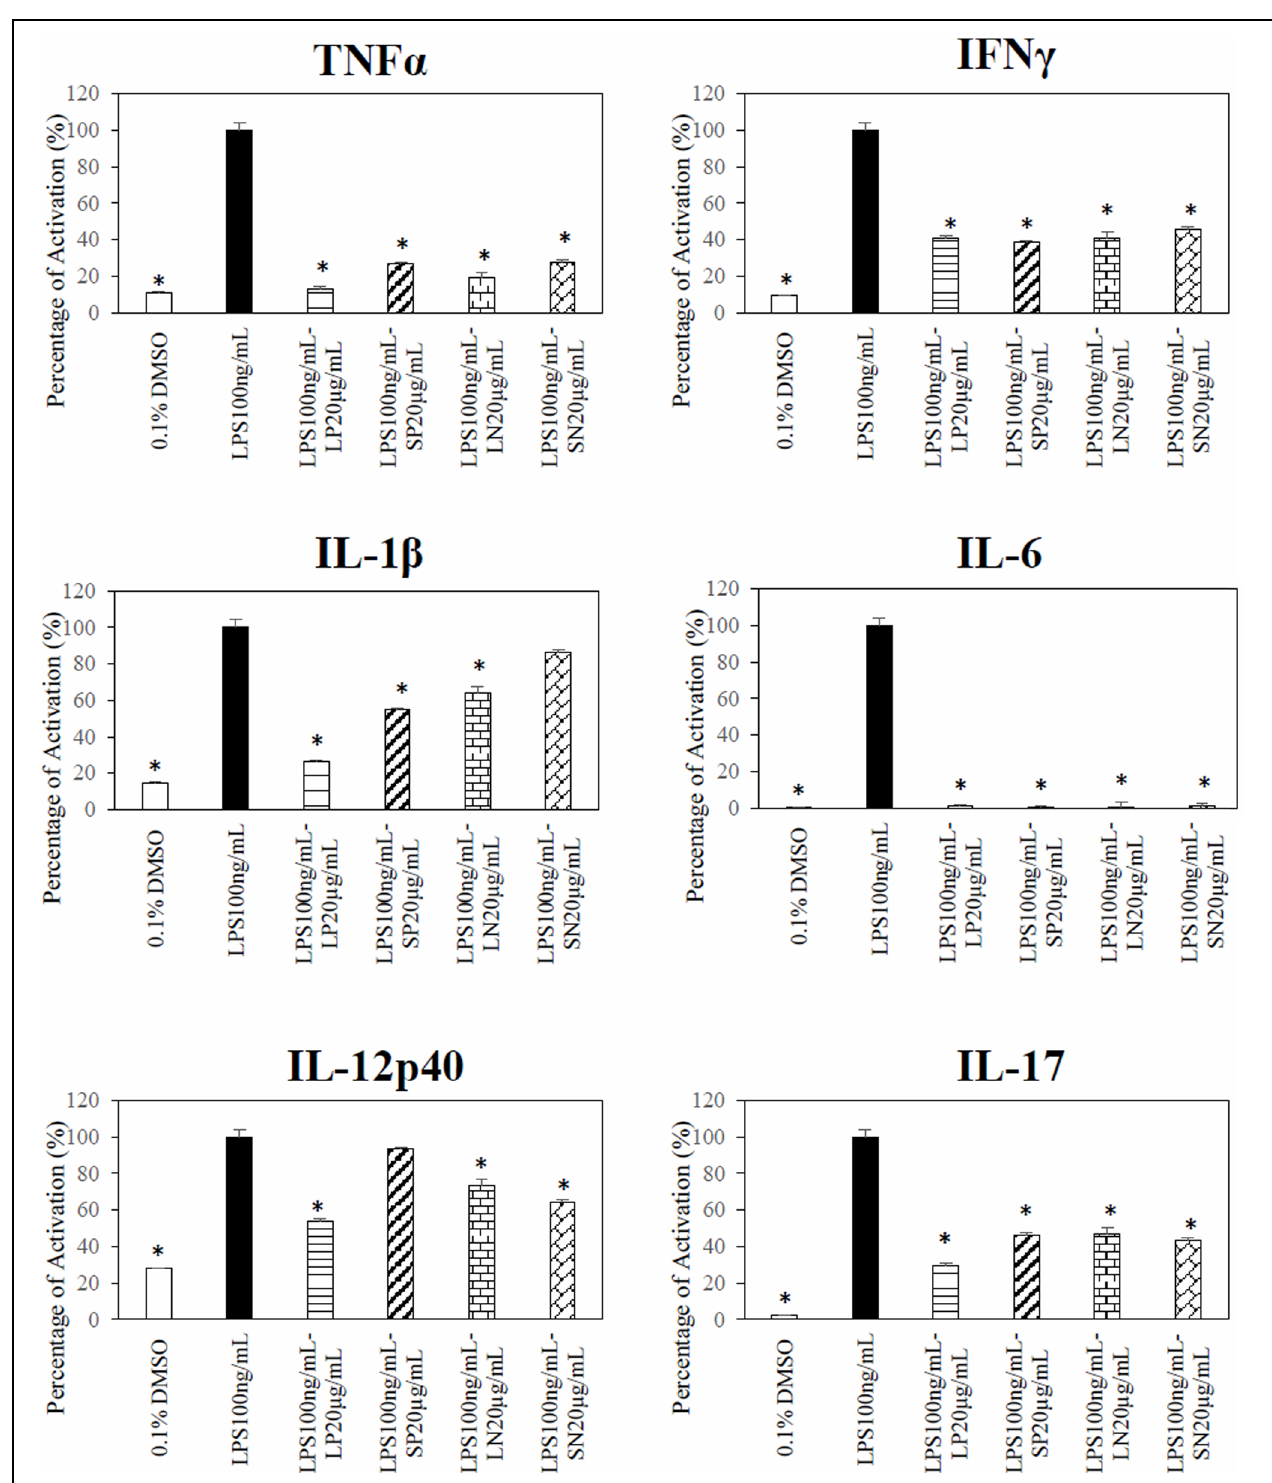
FIGURE 4 | Effect of C. nutans extracts on cytokines in RAW 264.7 cells. Cells treated with 20 μ g/mL of LP, SP, LN, or SN inhibited LPS induce significant cytokines production as compared to cells treated with 100 ng/mL of LPS ( ∗ p < 0.05, ANOVA post hoc Dunnett t -test).